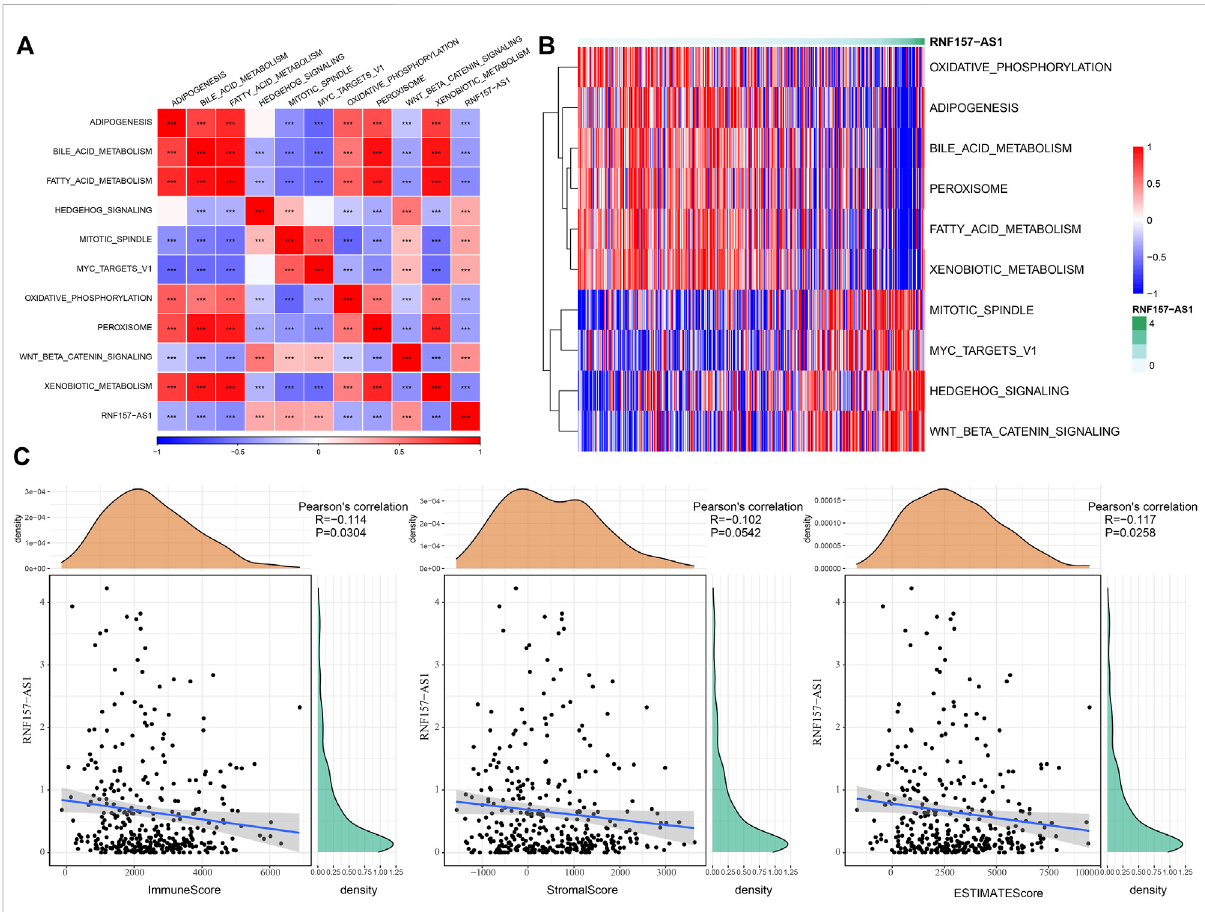
FIGURE 2 FunctionalpathwaysrelatedtoRNF157-AS1andtherelationshipbetweenRNF157-AS1andimmunein fi ltration. (A) Correlationanalysisbetween the enrichment of pathways and RNF157-AS1 expression. Red and blue indicate positive and negative correlations, respectively. (B) Heatmap showing the enrichment score of pathways ranked by increasing RNF157-AS1 expression. Darker green: higher expression. Red and blue: high and low expression levels, respectively. (C) Pearson correlation analysis of RNF157-AS1 with immune, stromal, and ESTIMATE